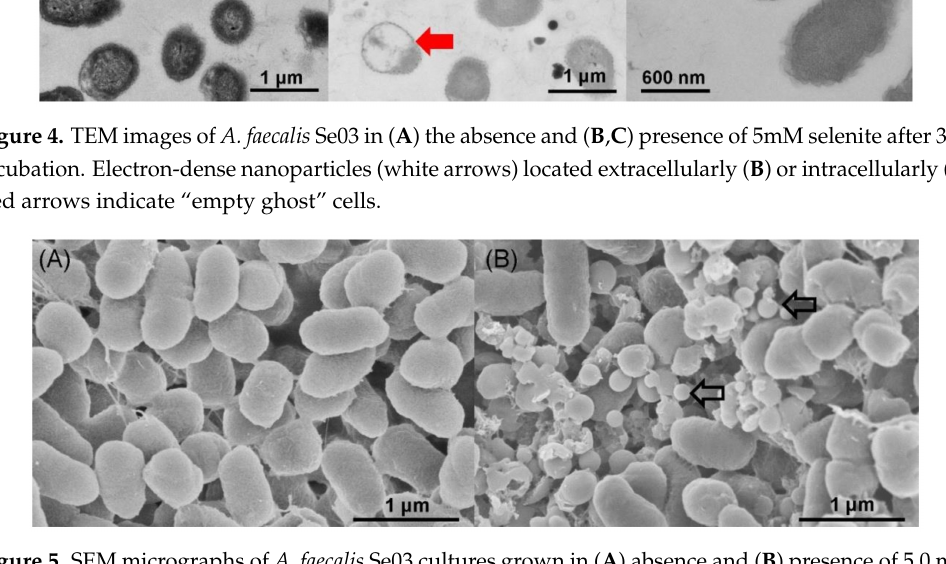
Figure 5. SEM micrographs of A. faecalis Se03 cultures grown in ( A ) absence and ( B ) presence of 5.0 mM selenite after 36h incubation. Electron-dense nanoparticles (white arrows) located